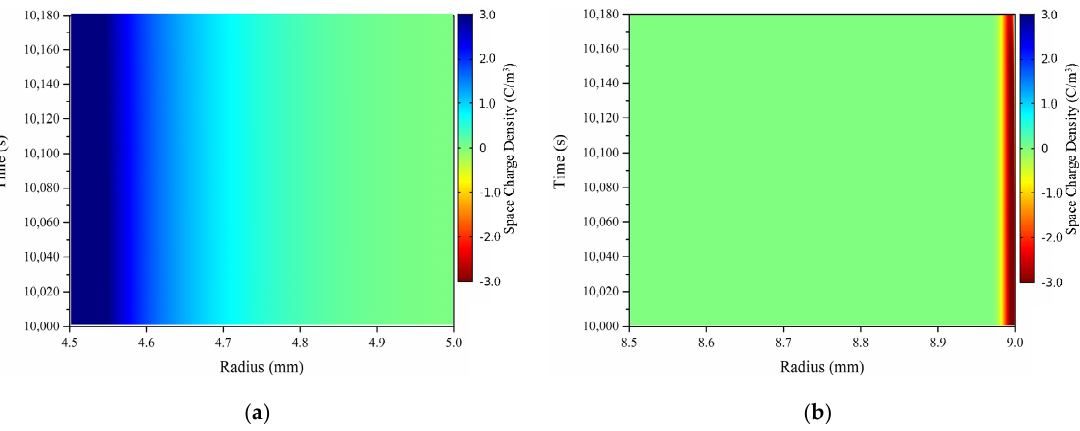
Figure 13. Space charge distribution at 250 A and potential zero duration 60 s: ( a ) Conductor side charge density (C/m 3 ); ( b ) sheath side charge density (C/m 3 ).